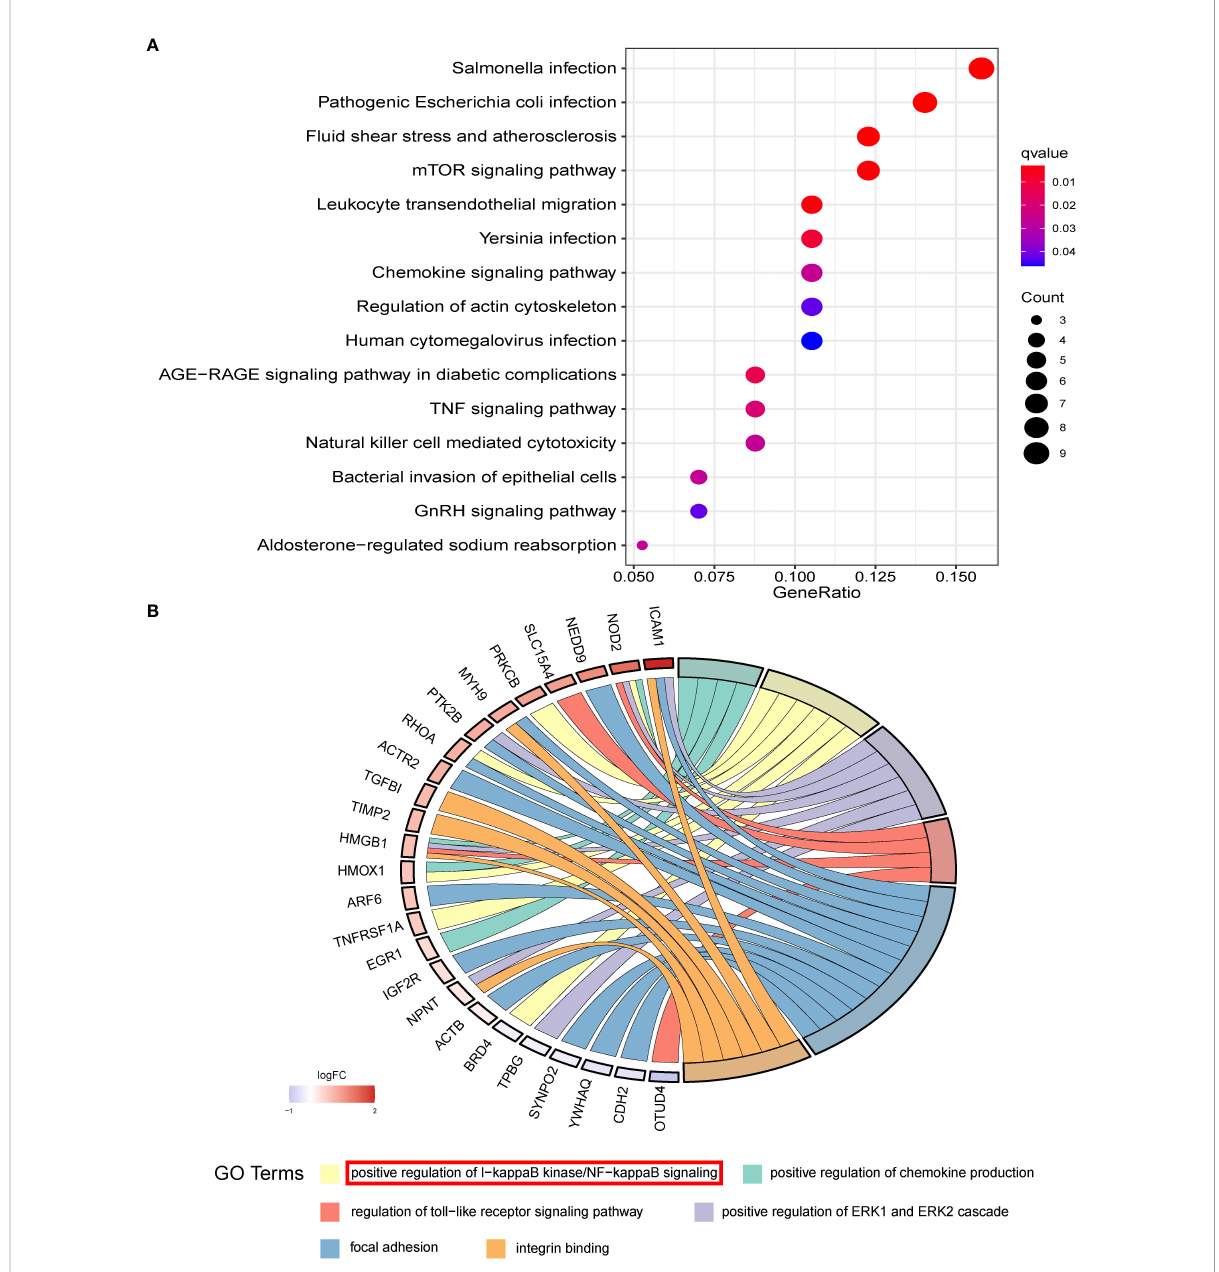
FIGURE 6 The functional enrichment results of overlapped DEGs. (A) The KEGG and (B) GO analysis of overlapped DEGs which may be potential targets of